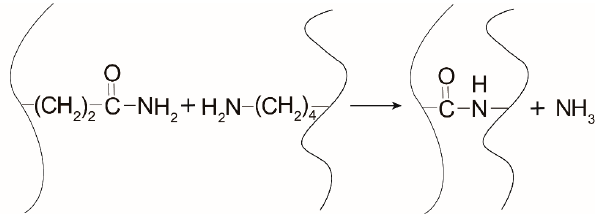
Figure 2. Enzymatic cross-linking of glutamine and lysine residues.